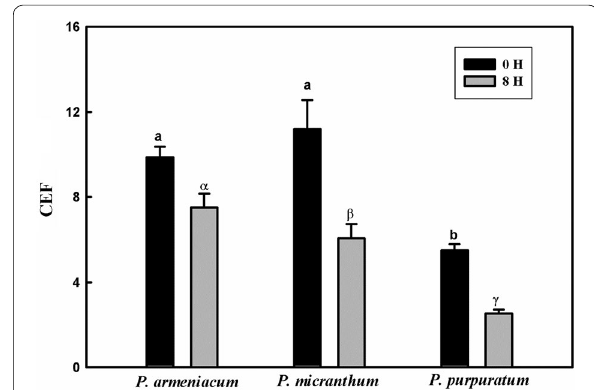
Fig. 11 The cyclic electron flow around PSI (CEF) at 200 μmol photons m − 2 s − 1 in three Paphiopedilum species after 8 h chilling stress. Each vertical bar represents Mean SE for four measurements ± from individual plants. Different letters above bars indicate significant differences between treatment (P < 0.005, based on ANOVA, followed by Tukey’s post hoc tests for